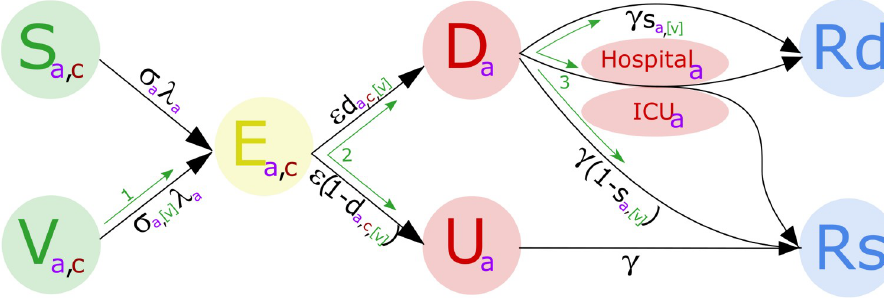
Fig 1. Representation of model states and transitions. Descriptions of model parameters are given in Fig 2. Individuals starting from the S (susceptible-unvaccinated) or V (susceptible-vaccinated) states move through the model to conclude in the R (recovered) or Rd (dead) states. Those in the asymptomatic, U, state all eventually recover, those in the symptomatic, D, state may either recover or die directly, or move into hospital and/or ICU before either recovery or death. Three different possible types of vaccination are shown by green arrows and bracketed variables. These are: 1. Reduction in susceptibility. 2. Reduction in becoming symptomatic. 3. Reduction in experiencing severe symptoms. Further model details may be found in the supporting information.